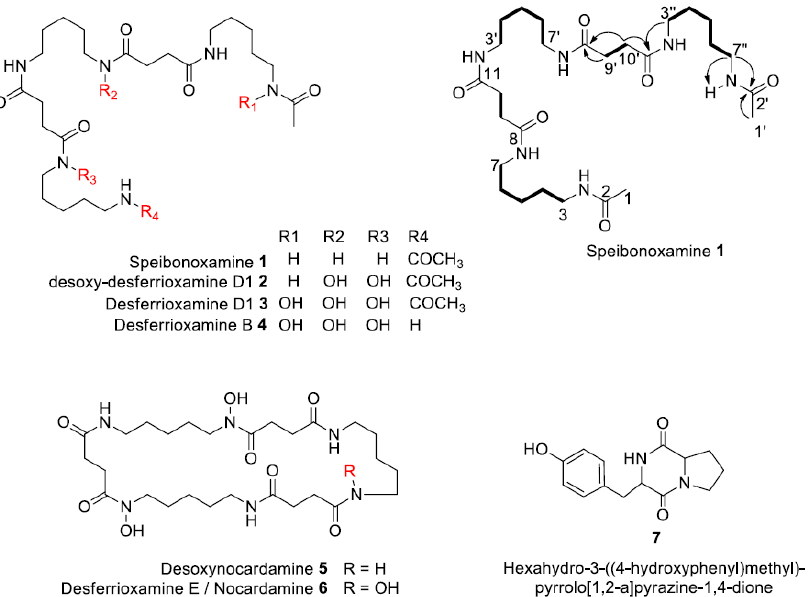
Figure 1. Structures of isolated metabolites 1 – 7 from the Kribbella speibonae strain SK5, including depiction of Speibonoxamine 1 with COSY ( — ) and key heteronuclear multiple bond correlations (HMBC) ( → ) correlations.